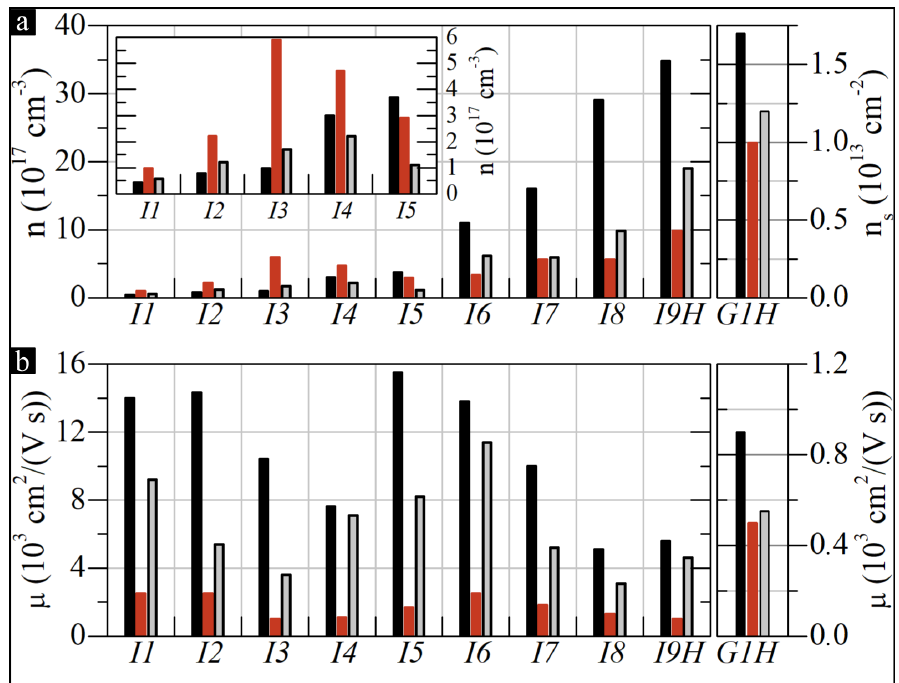
Figure 5. Charge carrier density ( a ) and mobility ( b ) in InSb and GR/SiC structures pre-NR, post-NR, and after the complete temperature